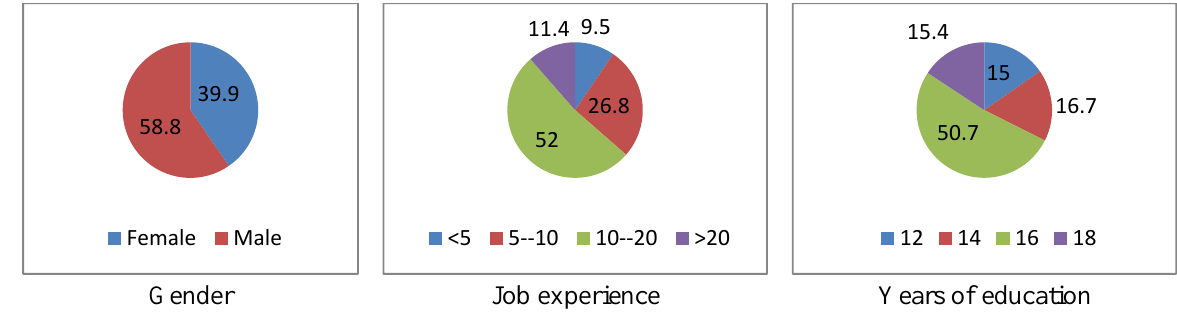
Fig. 2. Personal characteristics of the participants